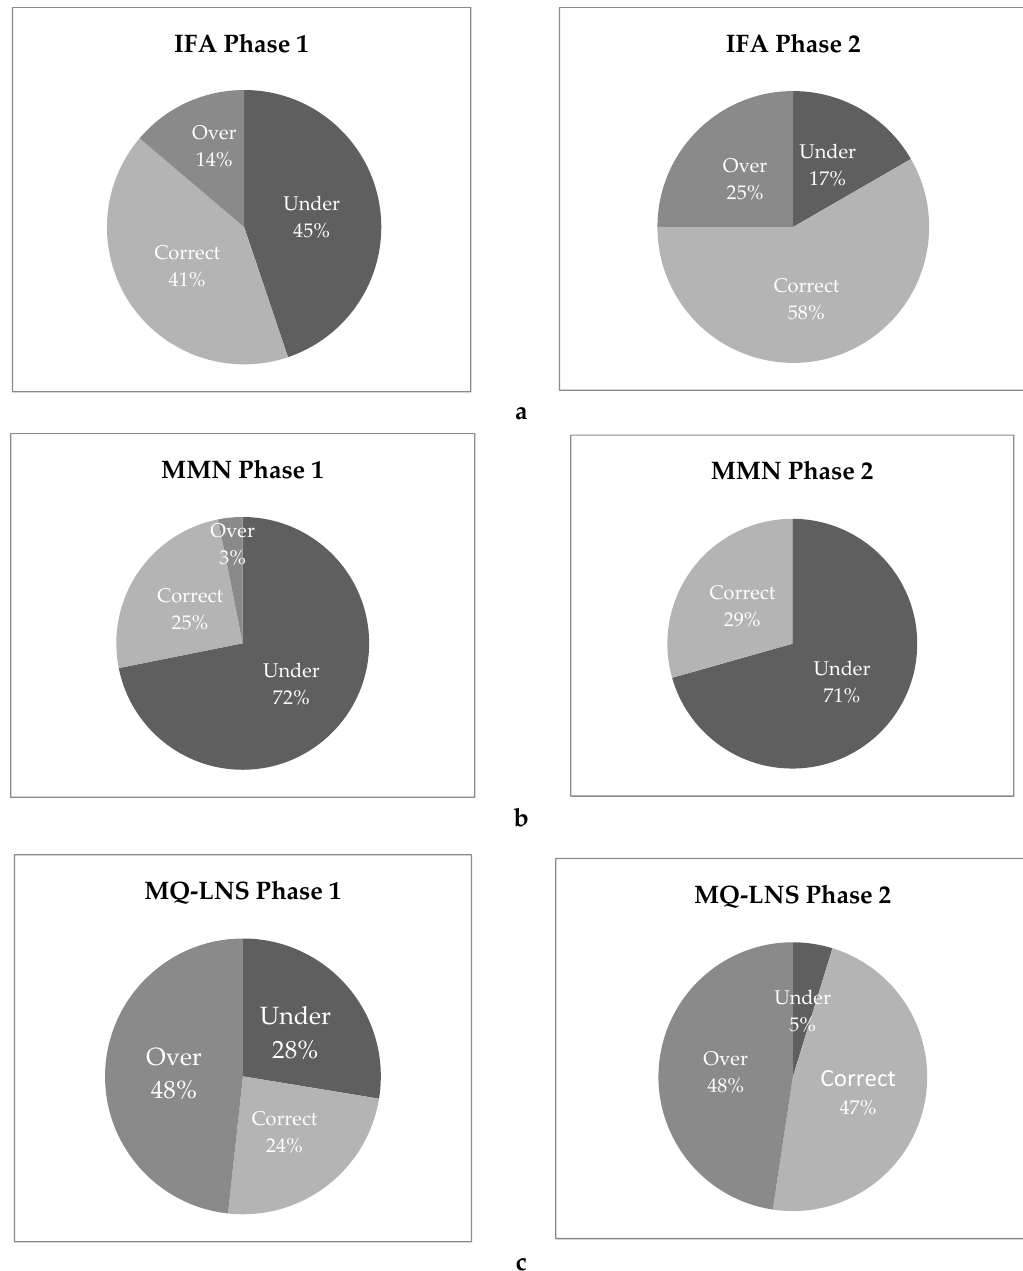
Figure 1. Spot check measure of supplement adherence by study arm and data collection phase: ( a ) IFA, ( b ) MMN, ( c ) MQ-LNS. Note: Correct supplement consumption is defined as having within +/ − 2 days’ supply of the expected number of supplements on hand at the time of the spot check.